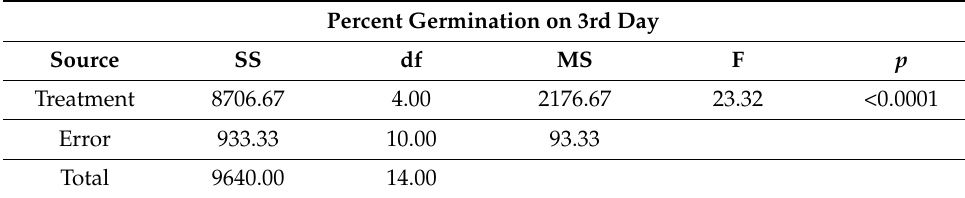
Table 1. ANOVA for seed germination with ANE treatments on the 3rd day of